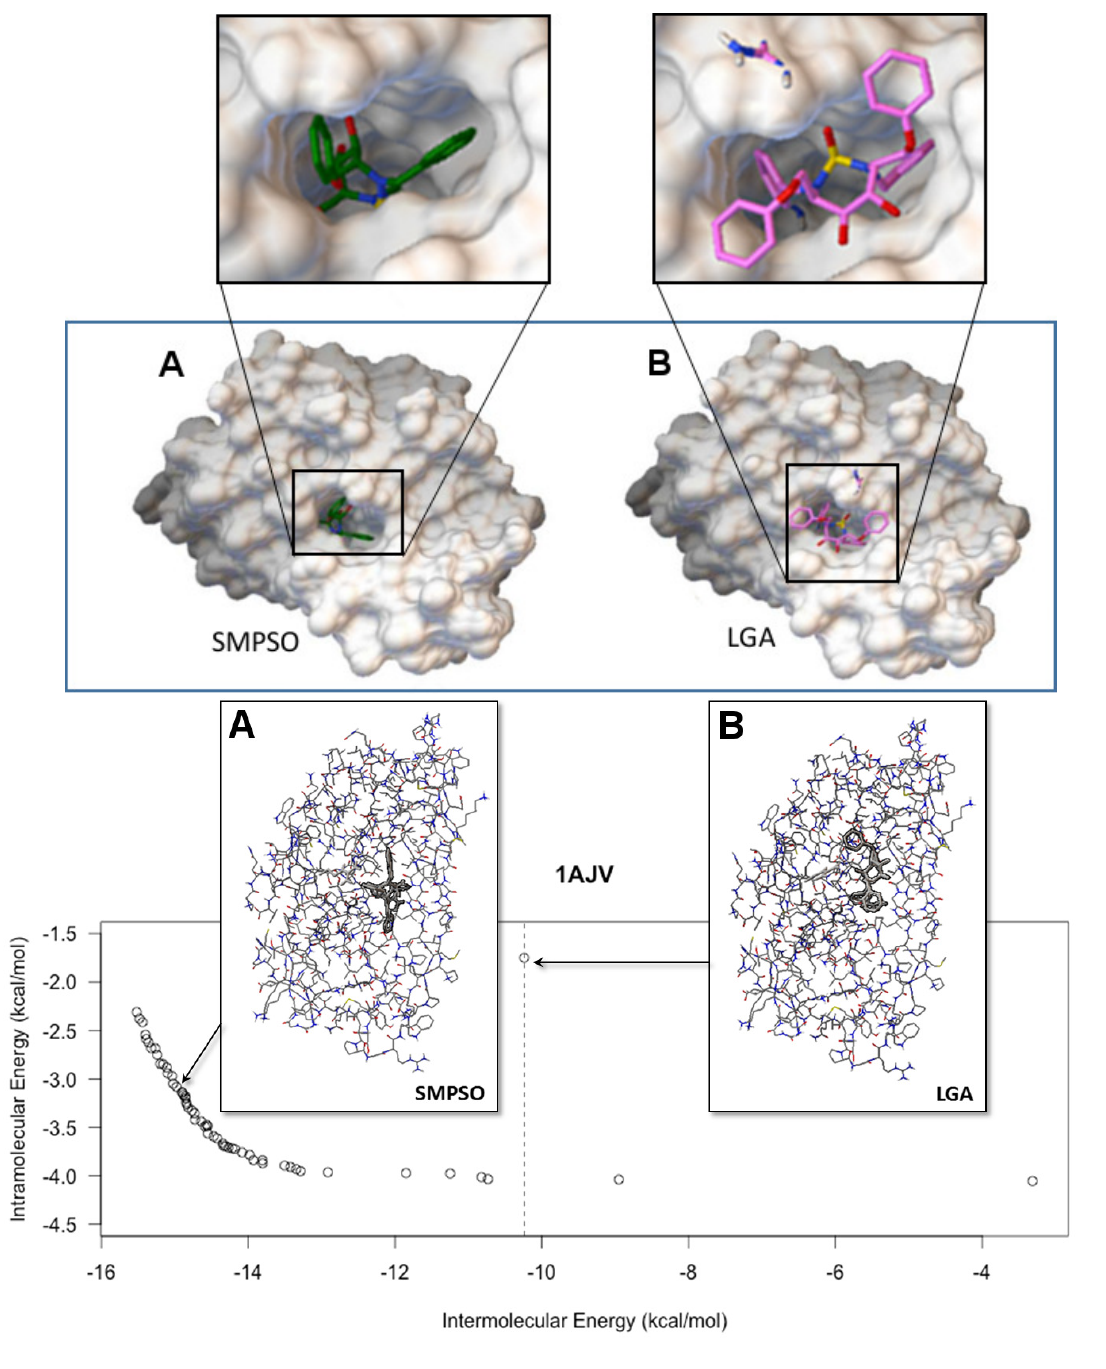
Figure 4. Front having the best hyper-volume value from SMPSO with regards to instance 1AJV. The point on the dashed vertical line is the best solution found by LGA, the mono-objective algorithm from AutoDock. All solutions placed on the left-hand side dominate that of LGA for the two optimized objectives. The macromolecule-ligand complexes resulted from the SMPSO and the LGA algorithms are represented in A and B,